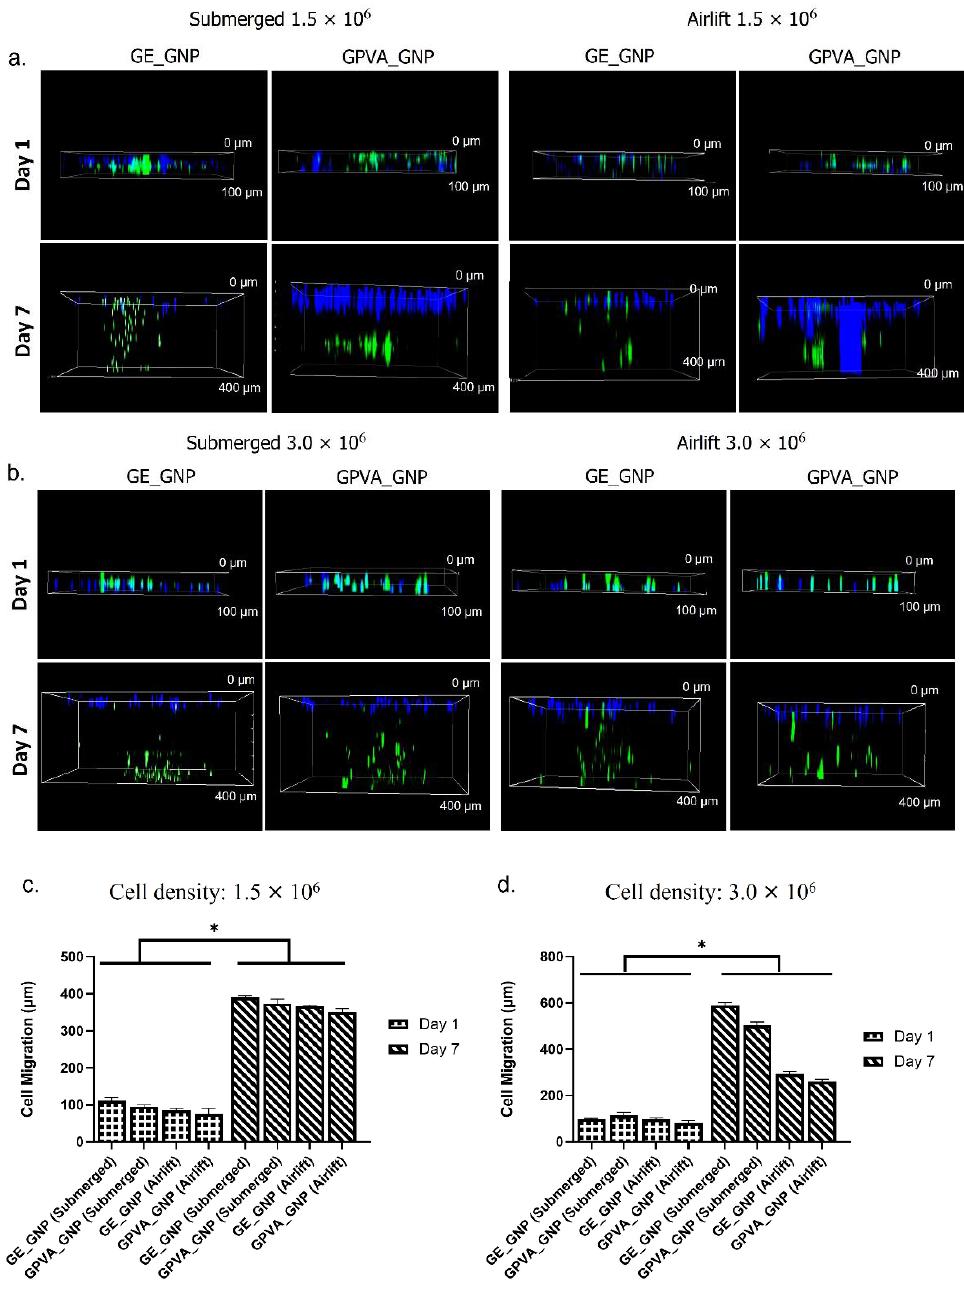
Figure 4. ( a ) 3D Confocal imaging of cell migration for 1.5 × 10 6 of cell density from day 1 until day 7. ( b ) 3D Confocal imaging of cell migration for 3.0 × 10 6 of cell density from day 1 until day 7. ( c ) Cell migration rate for 1.5 × 10 6 of cell density from day 1 until day 7. ( d ) Cell migration rate for 3.0 × 10 6 of cell density from day 1 until day 7. * indicates p < 0.05.